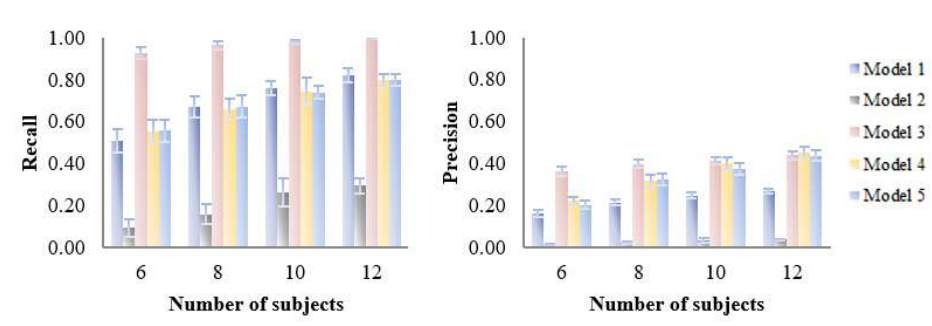
Figure 7. Influence of number of subjects (6–12) on the variable selection performance of five PLS models on simulated datasets. Recall and precision were calculated based on the variable selection confusion matrix. Table 3. Influence of the number of variables on variable selection performance of the five models on simulated data.